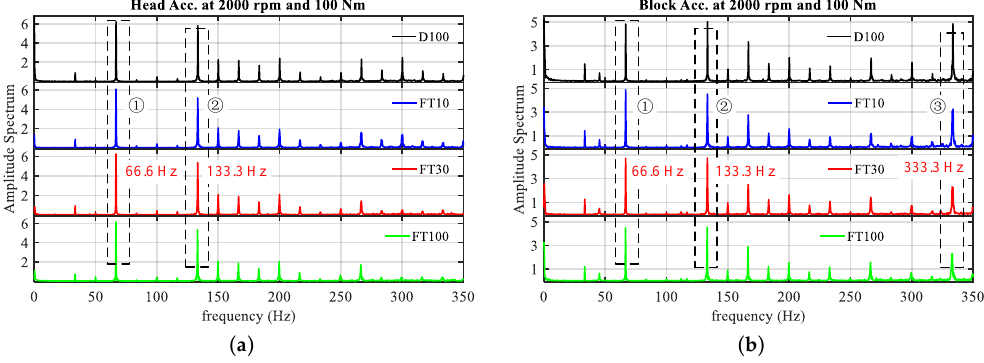
Figure 7. Low frequency band of engine vibration: ( a ) Head; ( b ) Block.